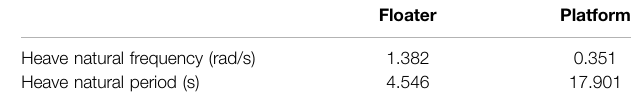
TABLE 4 | Natural frequency of the fl oater and